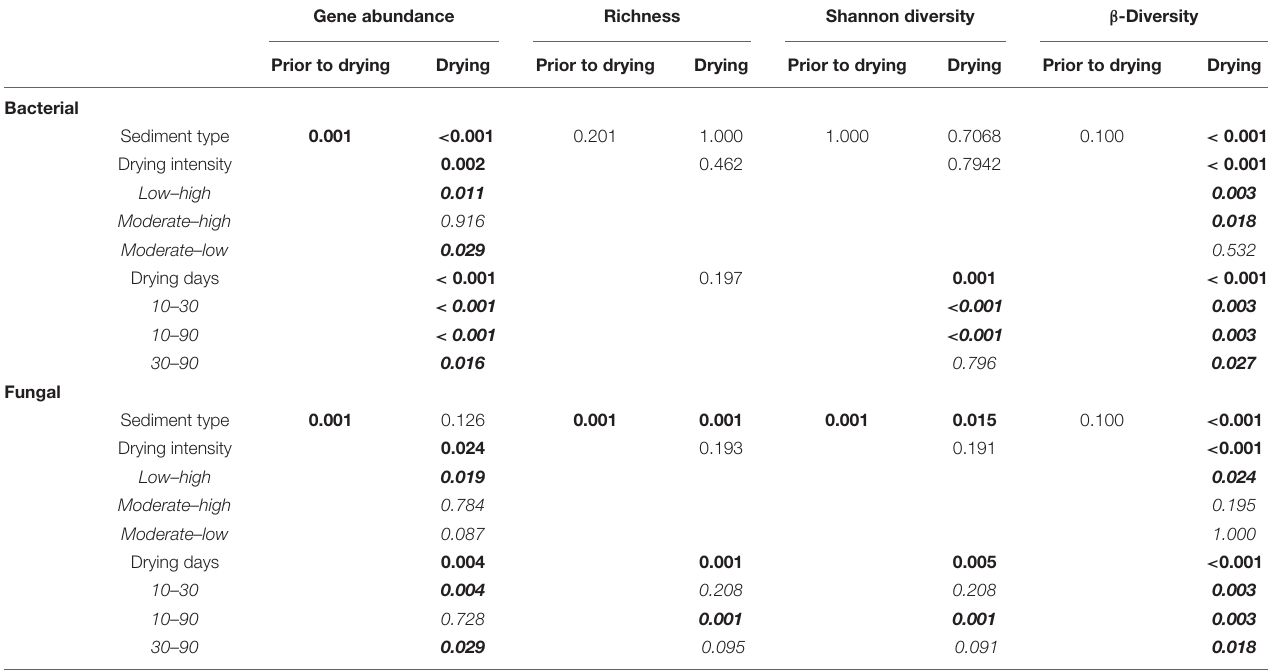
TABLE 1 | P -values from PERMANOVAs and post-hoc tests (Tukey’s HSD and pairwise) related to microbial communities diversity and